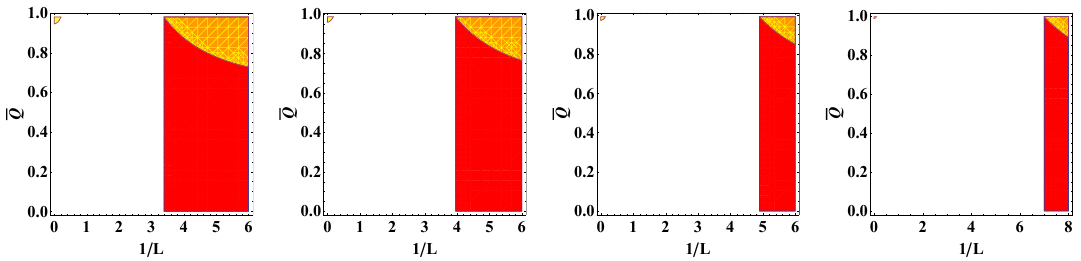
Figure 12 . The unstable regions of the AdS charged Gauss-Bonnet black hole. From the left to the right (cid:11) = (cid:0) 0 : 04 ; (cid:0) 0 : 03 ; (cid:0) 0 : 02 and (cid:0) 0 : 01, respectively, where the red region corresponds to f 1 < 0, the yellow region correspond to f 2 < 0 and the orange region is their overlap which belongs to the stable region. Here we take ‘ =